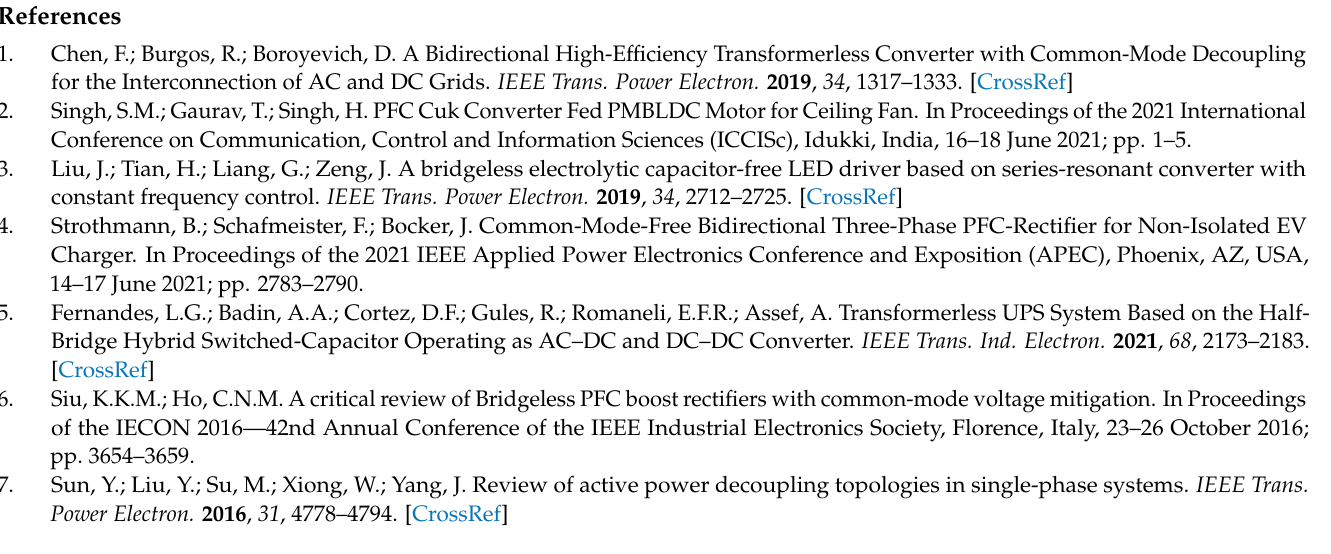
Figure 15. Total harmonics distortion (THD) at different power levels.